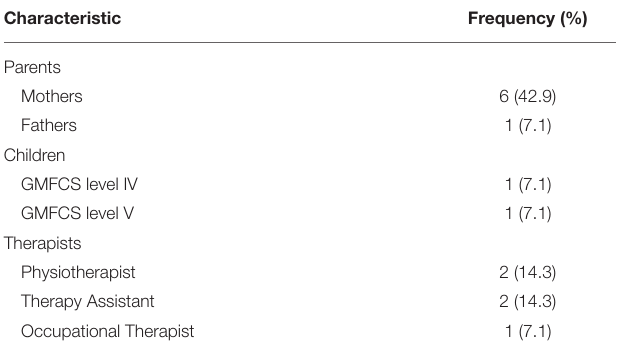
TABLE 2 | Participant characteristics ( n =